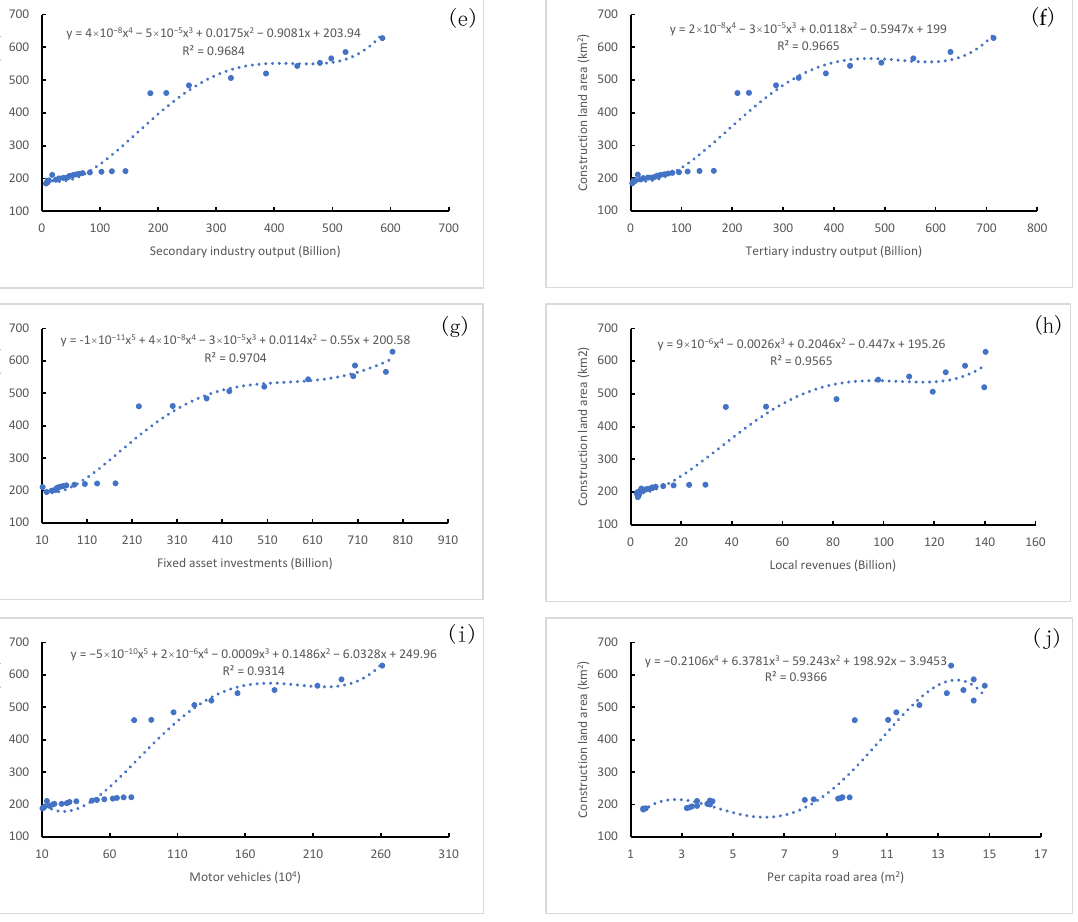
Figure 5. Relationships between construction land area and ( a ) total population, ( b ) non-agricultural population, ( c ) GDP, ( d ) primary industry output, ( e ) secondary industry output, ( f ) tertiary industry output, ( g ) fixed asset investments, ( h ) local revenues, ( i ) motor vehicles and ( j ) per capita road area during 1987–2016 in Wuhan.